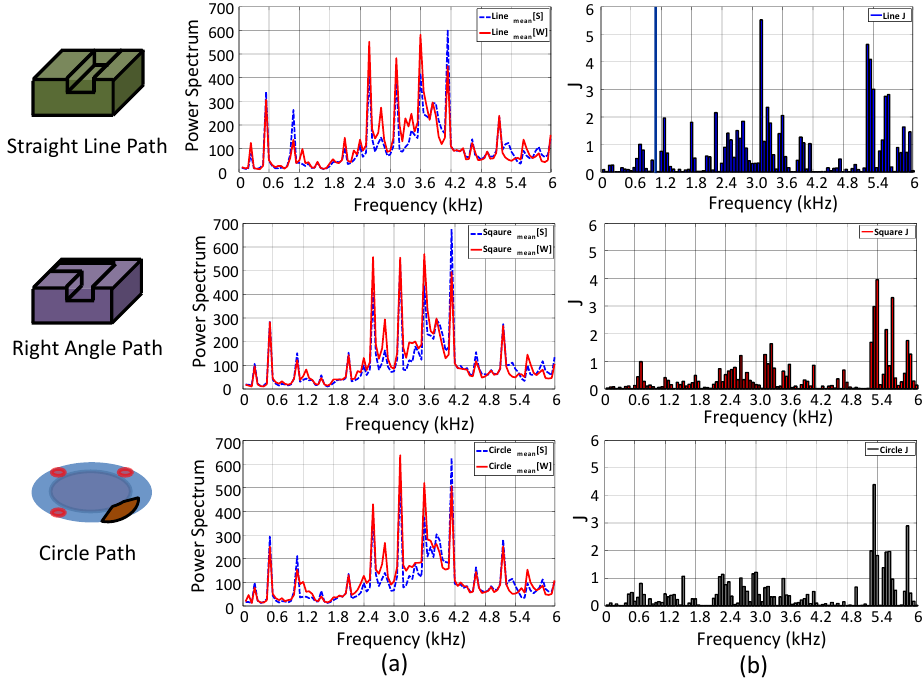
Figure 11. Frequency domain vibration signal in the x-direction and scatter index for sharp and worn tools: ( a ) frequency domain signals; ( b ) classification index J (60 Hz).